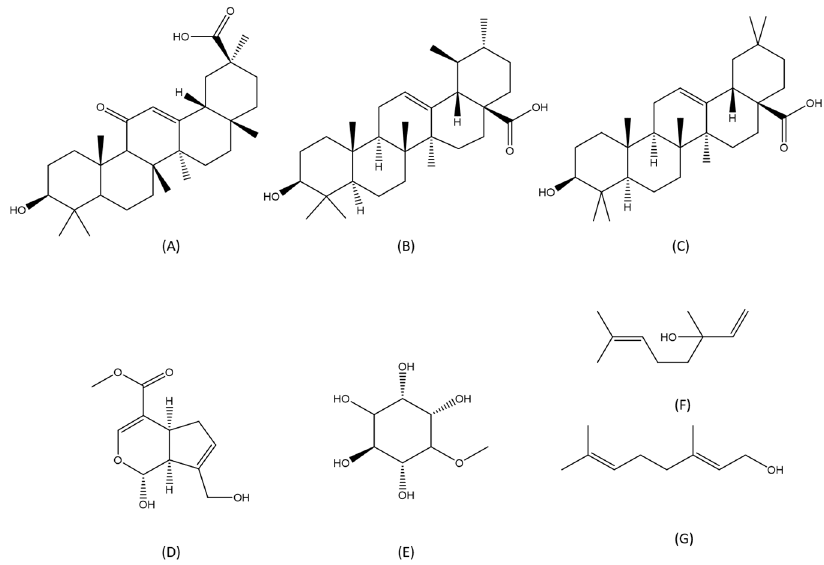
Figure 4. Chemical structures of terpenoids with potential preventive effects of aucte kidney injury.